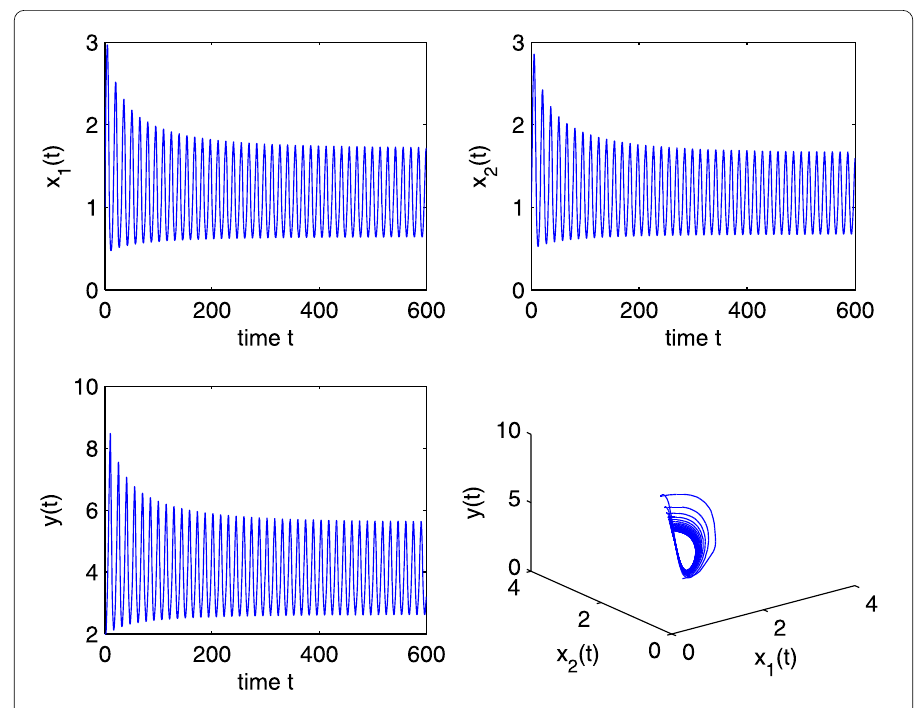
Figure 2 When τ 1 = 0, E ∗ undergoes a Hopf bifurcation for τ 2 = 1.98 > τ 20 = 1.9387